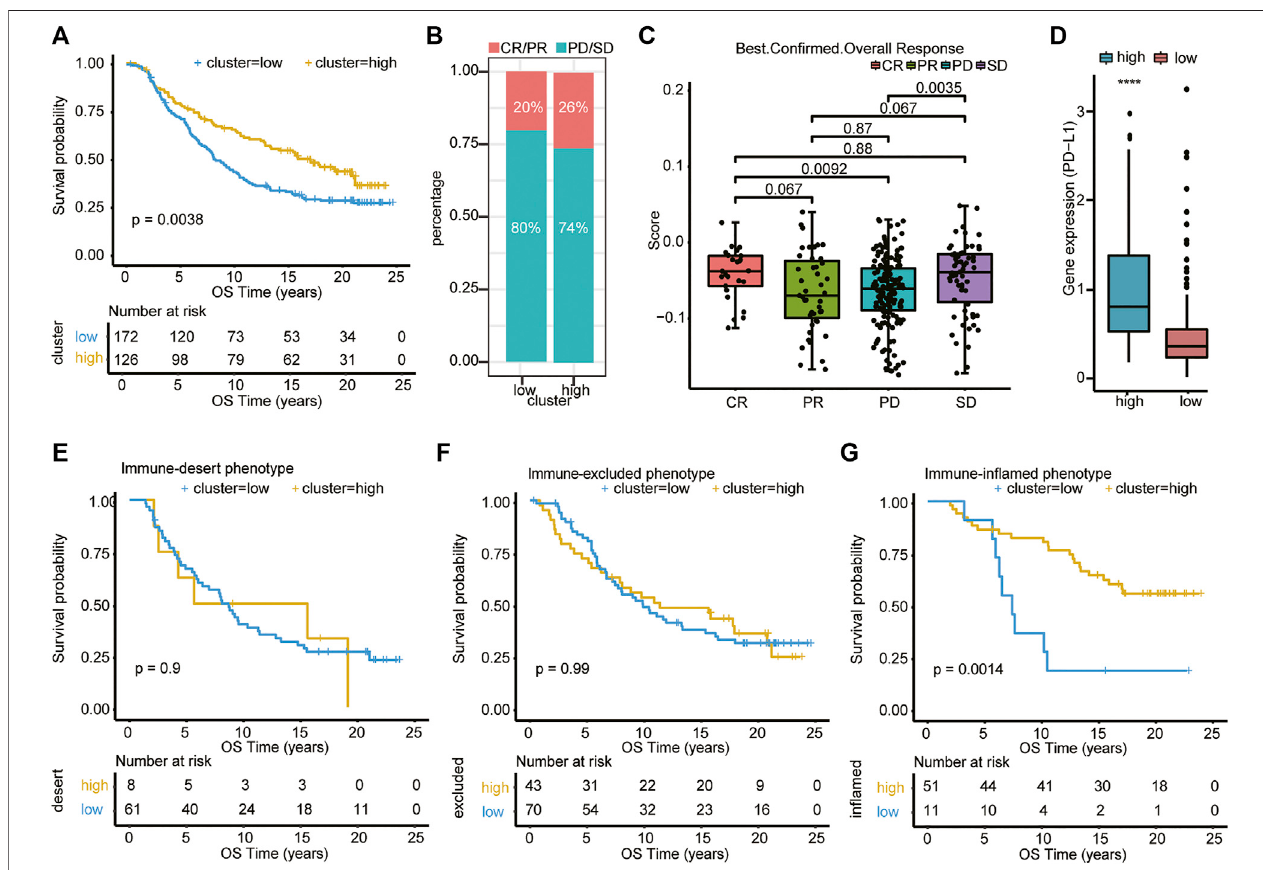
FIGURE 7 | Association of type 1 T helper cell – related signature-based risk score with immunotherapy ef fi cacy. (A) Univariate Cox analysis and Kaplan – Meier curves show that patients who received immunotherapy with high risk scores exhibited prolonged overall survival. (B – C) The distribution of immunotherapy responsiveness between two clusters was shown. p -value was calculated with one-way ANOVA test. (D) The PD-L1 expression level in the two clusters. (E – G) Kaplan – Meier curves show the survival difference in the immune subtypes, including desert, excluded, and in fl amed subtypes between the high- and low-risk clusterswithin theIMvigro210 cohort. Abbreviations:CR,complete remission; OS, overall survival; PD, progressive disease; PDAC, pancreatic ductal adenocarcinoma; PR, partial remission; SD, stable disease; PD-L1, programmed death-ligand 1; OS, overall survival.